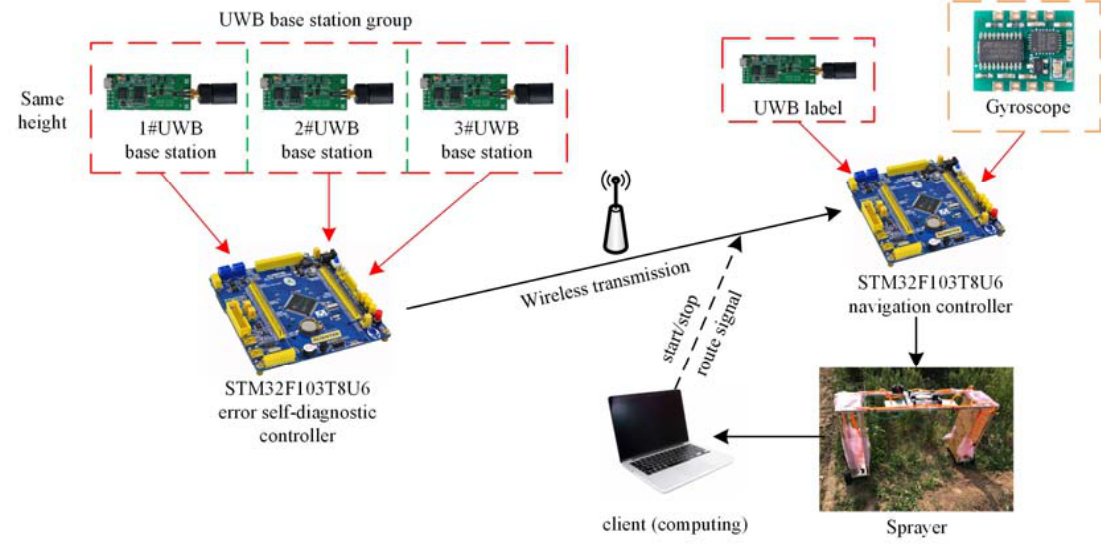
Figure 7. Autonomous marching system.